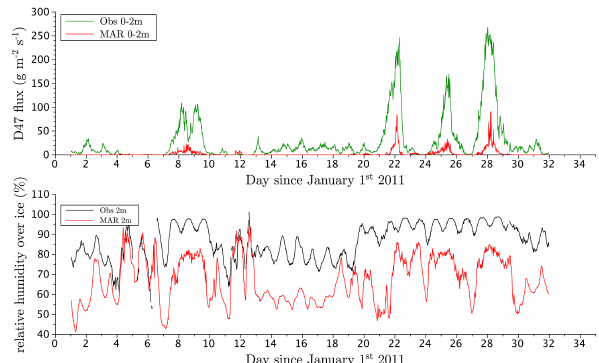
Figure 6. Top: observed (green) and simulated (red) snow mass fluxes from 0 to 2m. Bottom: observed (black) and simulated (red) relative humidity 2m above the surface.